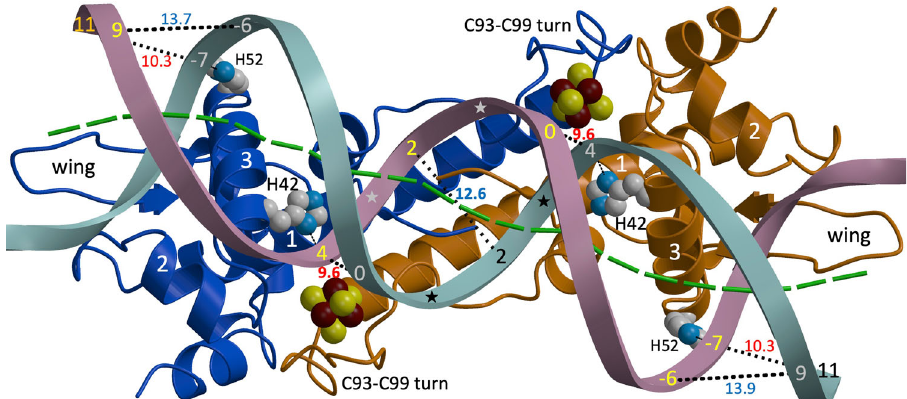
Fig. 1 Top view of the Sc NsrR/ hmpA1 operator complex. NsrR subunits C α tracings are depicted in blue and gold with ribbons indicating α -helices and arrows β -strands. DNA strands carry nucleotide numbers and are shown as cyan and burgundy ribbons, with stars marking four B II backbone conformations in the central region. Cluster atoms and histidine side chains forming hydrogen bonds to phosphate groups are depicted as spheres (Fe: red- brown, S: yellow, N: blue and C: gray). The fi rst three helices and the labeled wing loop of each protein subunit interact with the DNA. Minimal and maximal P-to-P distances between phosphate groups across the minor groove are indicated with dotted lines and given in Å. The green dashed line follows the bp origins of the DNA double helix as determined with the program DSSR 37